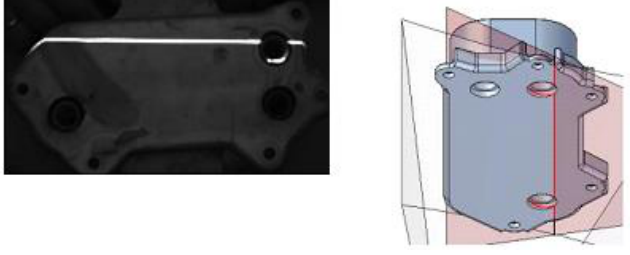
Figure 3. Laser reflections in the wall of the hole,  = 70  .